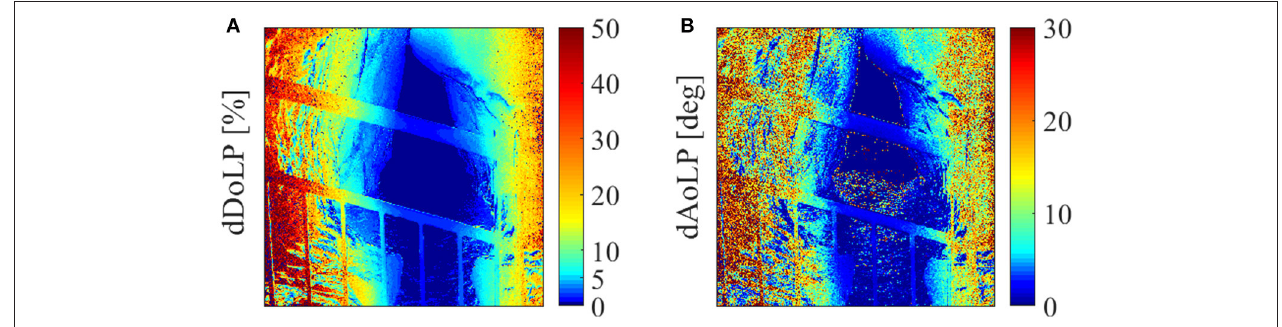
FIGURE 9 | Error estimation of (A) DoLP (dDoLP) and (B) AoLP (dAoLP) of cave walls (long exposure) as calculated per pixel, on April 10th, at 10a.m.